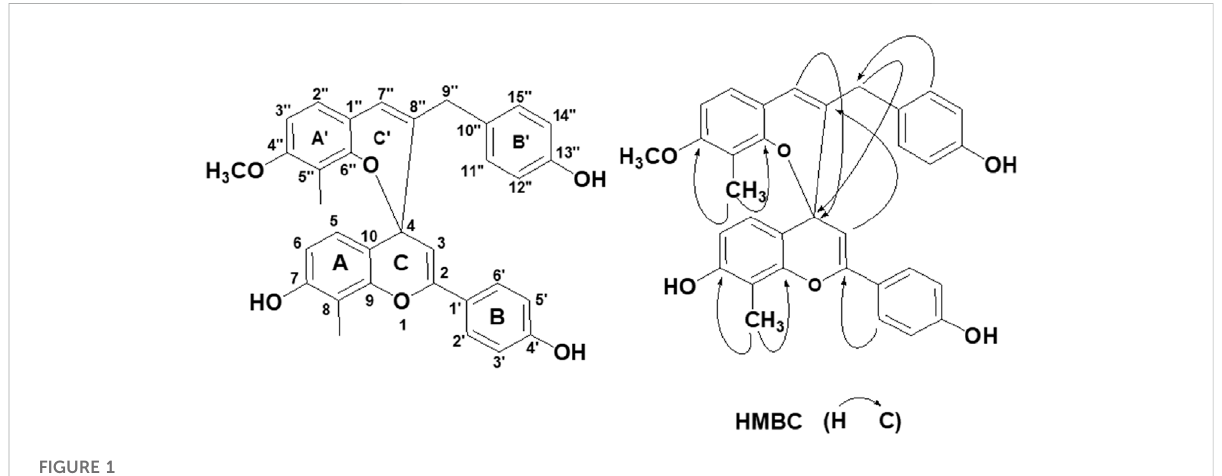
FIGURE 1 Structure of RFA and the key HMBC